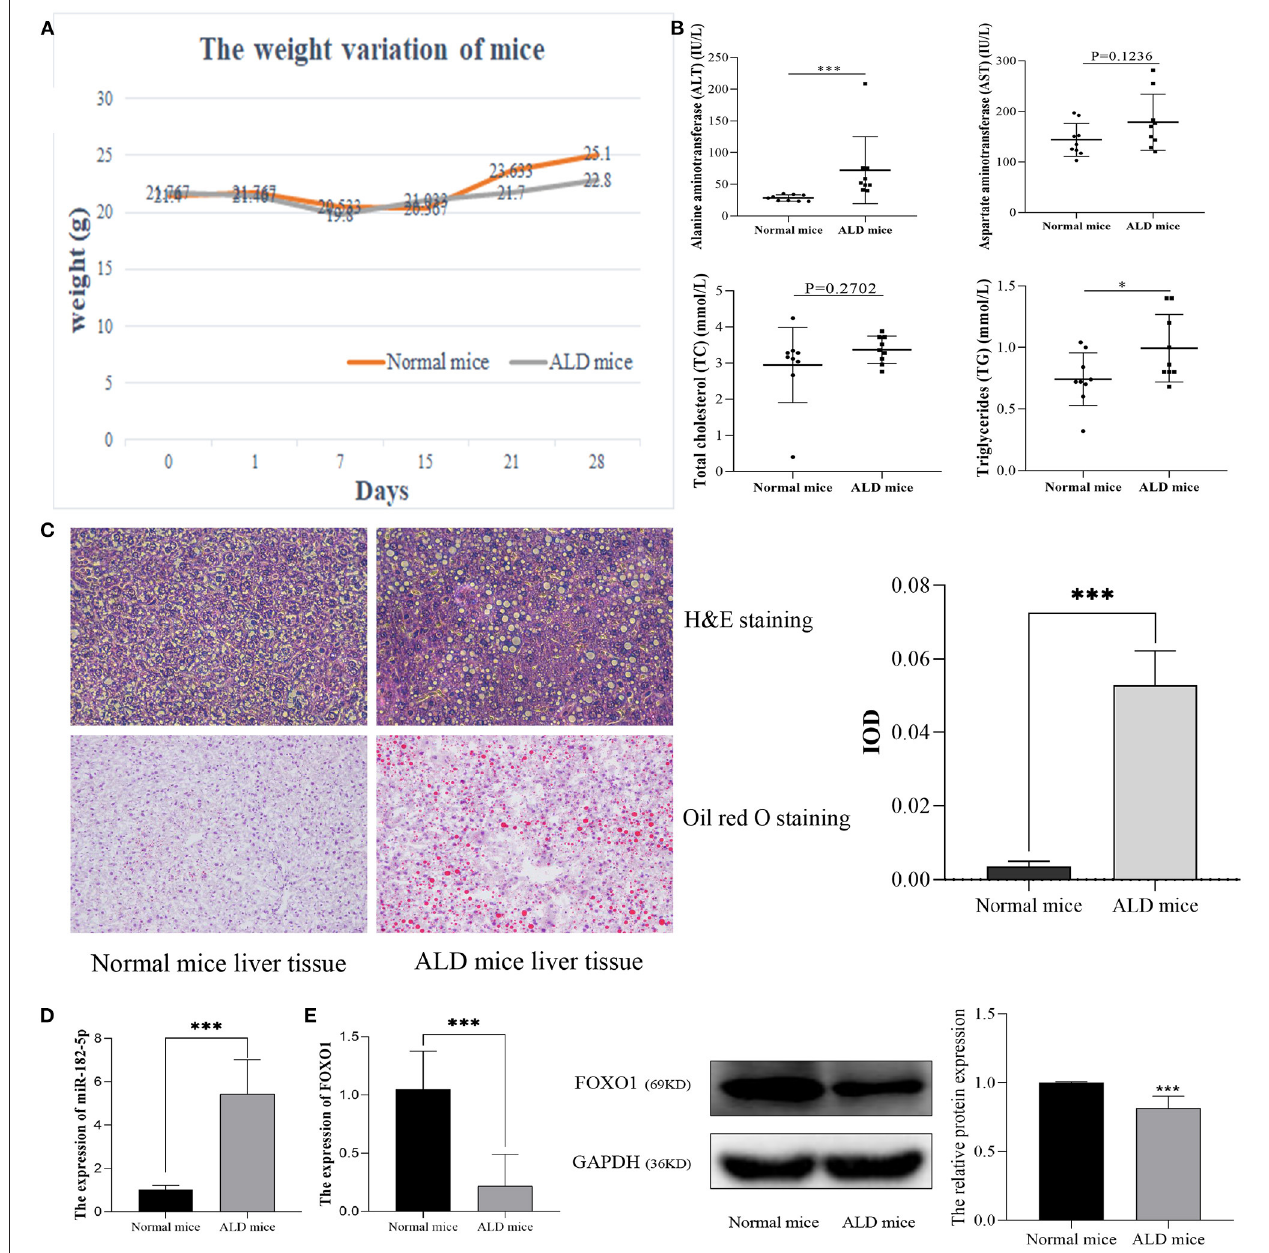
FIGURE 4 | Validation of the expression of miR-182-5p and FOXO1 in the ALD mice model. (A) Weight variation in ALD mice, (B) biochemical characteristics of ALD mice, (C) liver tissue H&E, Oil Red O staining ( × 40), and IOD analysis, (D) expression of miR-182-5p between ALD mice and normal mice, (E) quantitative real-time PCR and western blotting results of FOXO1 in ALD mice, respectively. ALD, alcoholic liver disease; ALT, alanine aminotransferase; AST, aspartate aminotransferase; TG, triglycerides; TC, total cholesterol. * p < 0.05, *** p < 0.001.